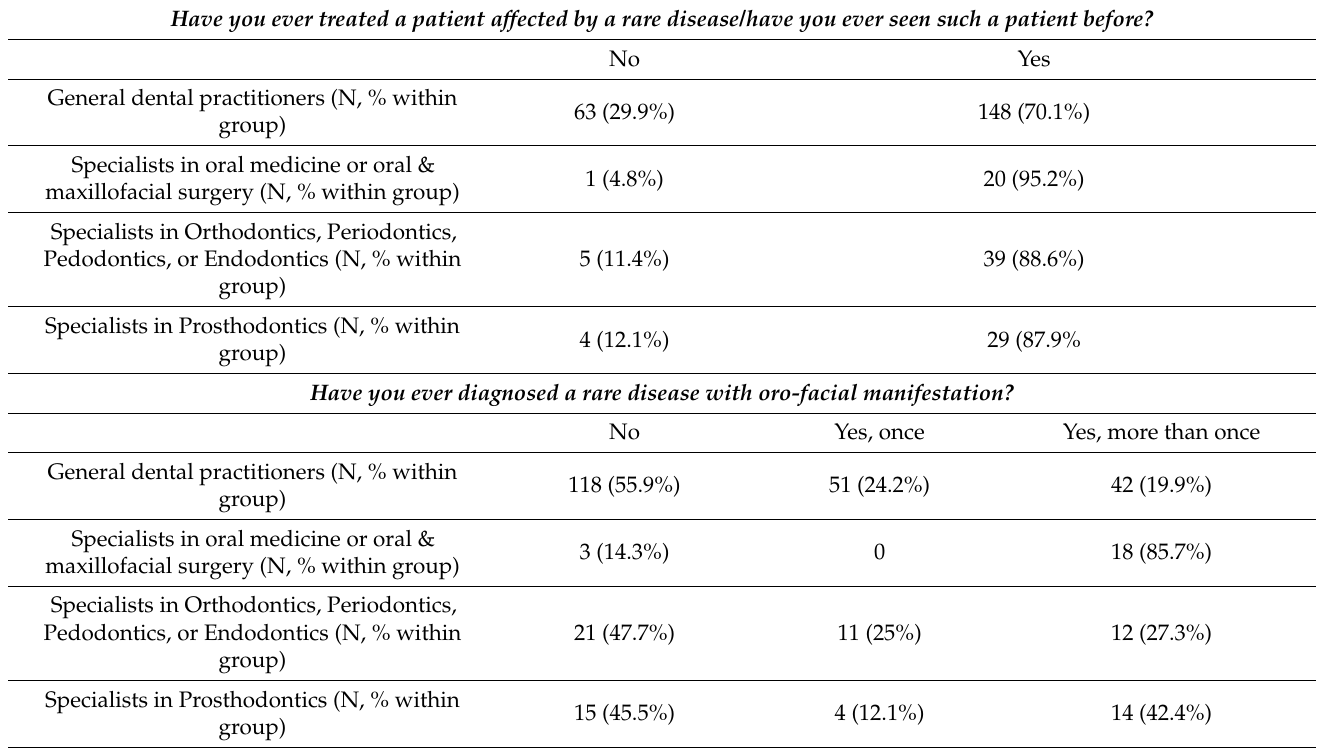
Table 5. Breakdown of dentists with previous diagnosis or treatment of a patient having a rare disease with oromaxillofa- cial